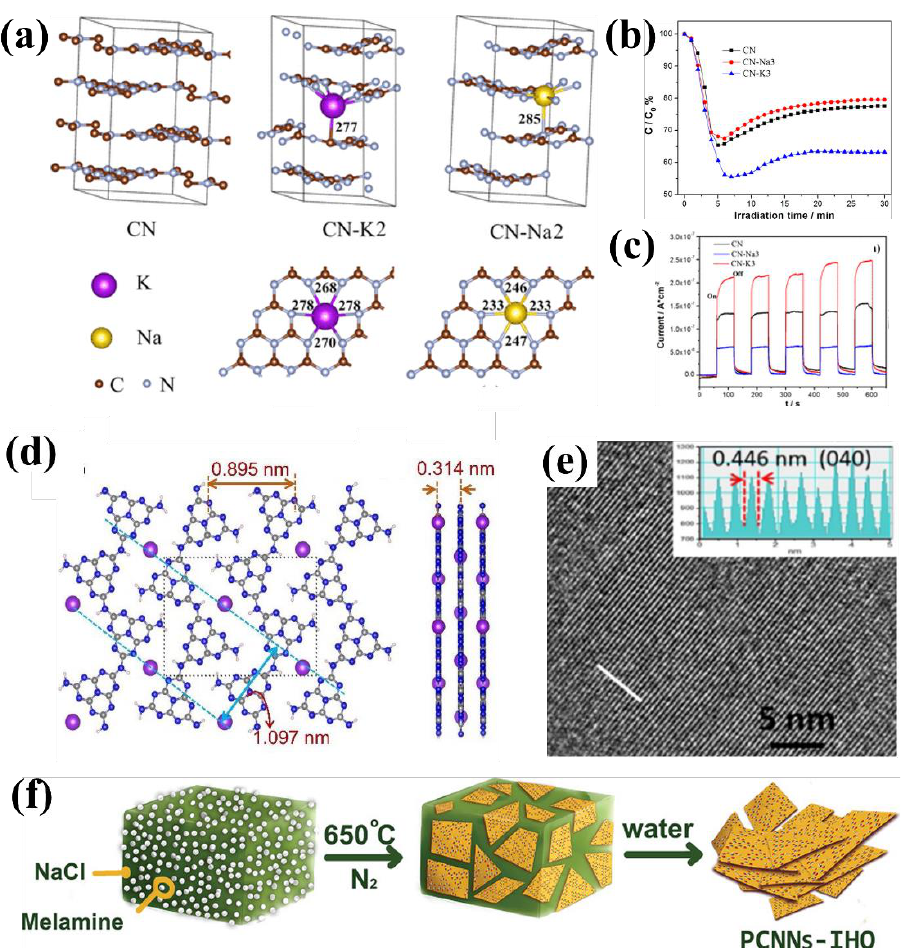
Figure 3. ( a ) Calculated crystal structures, ( b ) photocatalytic oxidation of NO activity and ( c ) transient photocurrent responses of CN, CN – K and CN – Na [35]. ( d ) Schematic diagram and ( e ) HRTEM image of CCN prepared by solid KCl method [44]. ( f ) Illustration of the synthesis process of PCNNs-IHO [45].